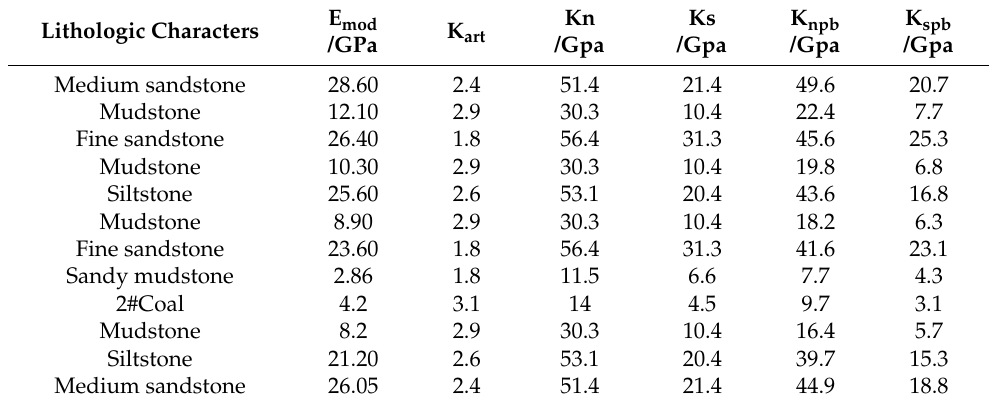
Table 3. Particle model microphysical and mechanical